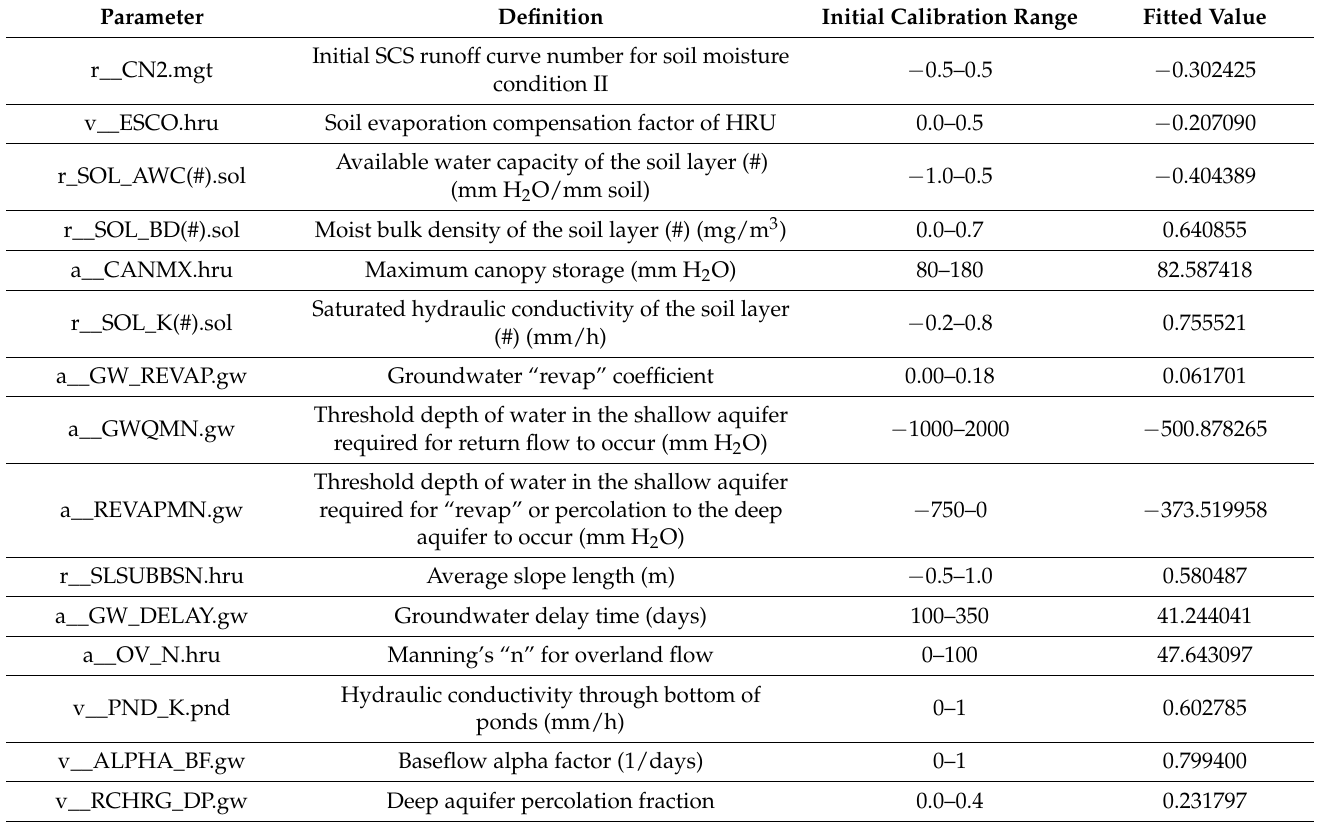
Table 2. Parameters used in the calibration with SWAT CUP, their initial calibration range and the value fitted after calibration, small letter before the parameters represents the mode of adapting the parameter during the calibration (r = relative, v = replace, a =